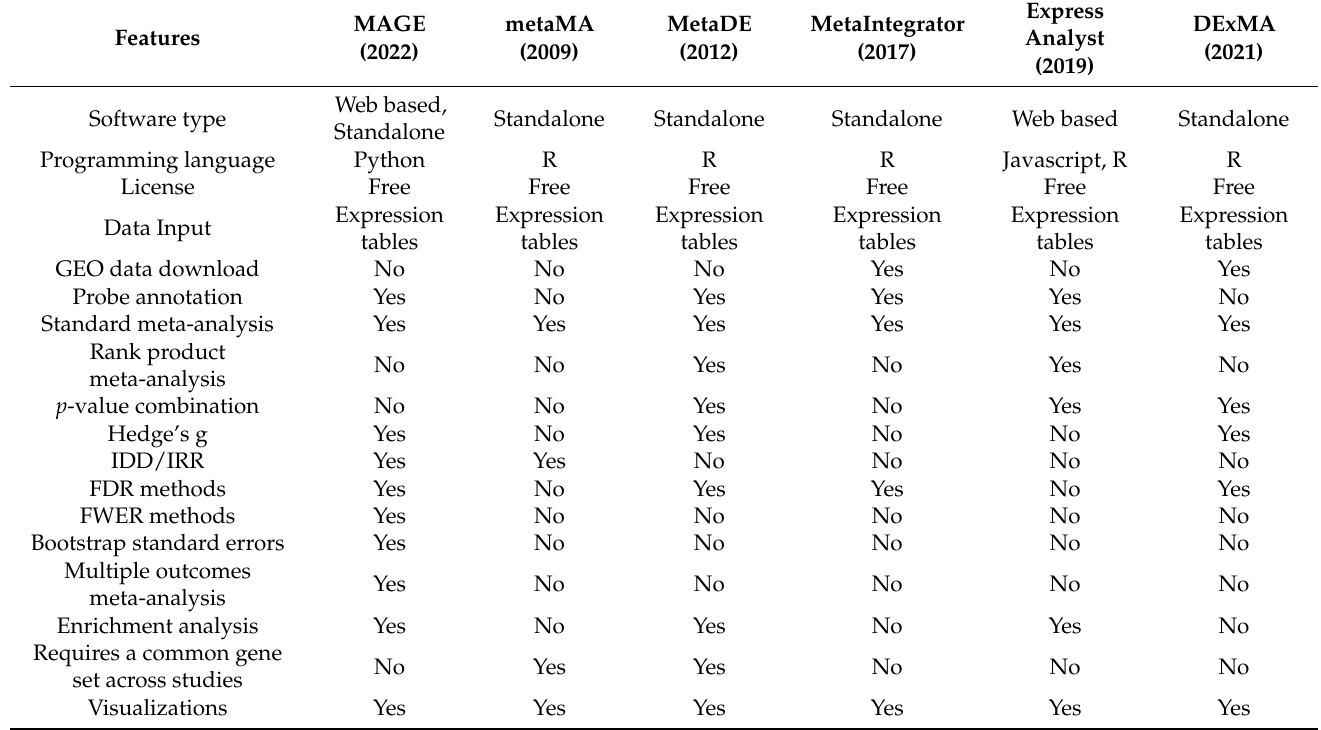
Table 1. Comparison of features available in packages for the meta-analysis of gene expression.